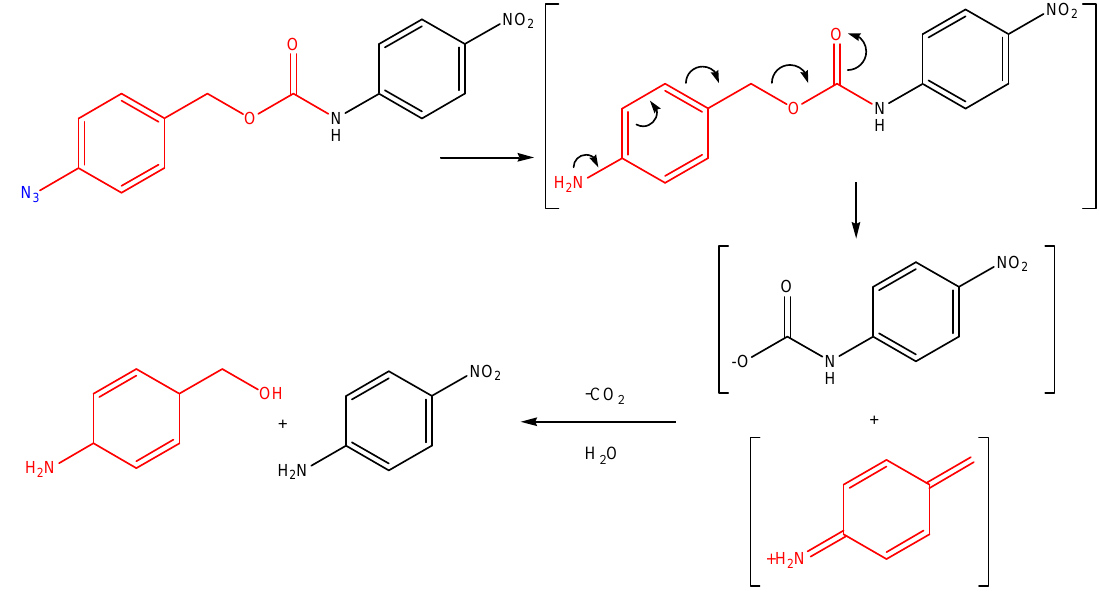
Scheme 6 . Activation of the 4-azidobenzyloxycarbonyl prodrug